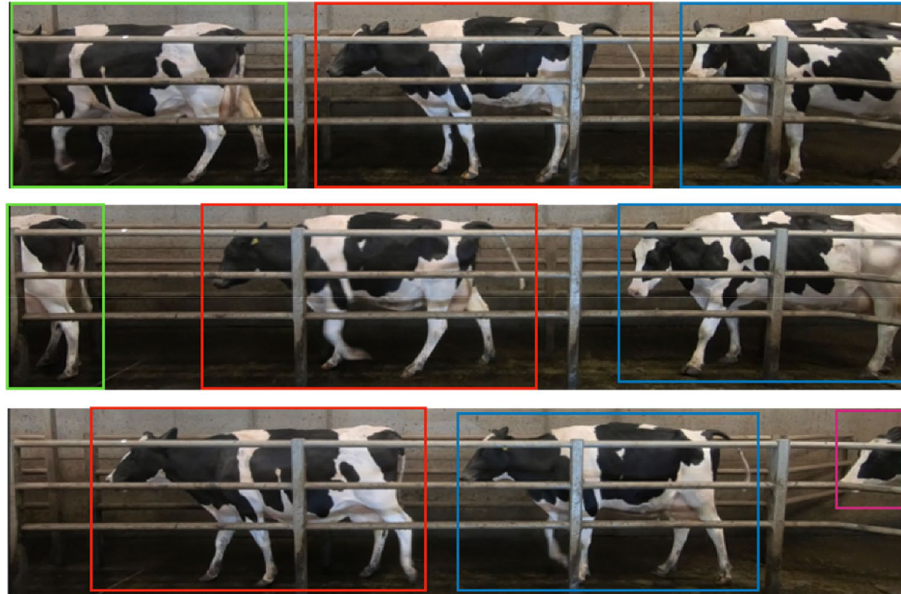
Figure 10. Visualization of the tracking algorithm. The top image shows three cows in the first frame, each marked with a different colour bounding box. The second frame down shows the cows 1 s later with the tracking algorithm associating the correct cows with the coloured bounding box. The bottom frame again shows the cows 1 s after the second